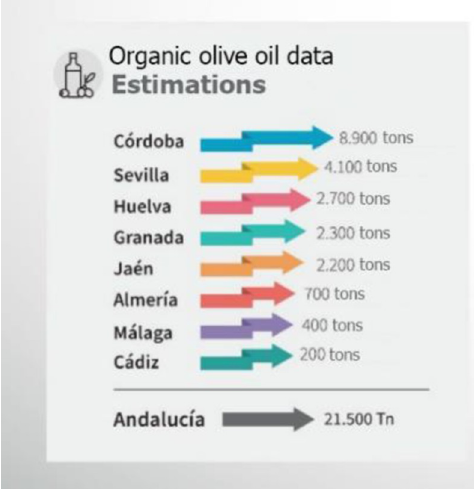
Fig 2. Organic oil production in Andalusia for the 2021–22 season. Source: Prepared by the authors based on information from the Agricultural and Fisheries Agency (Junta de